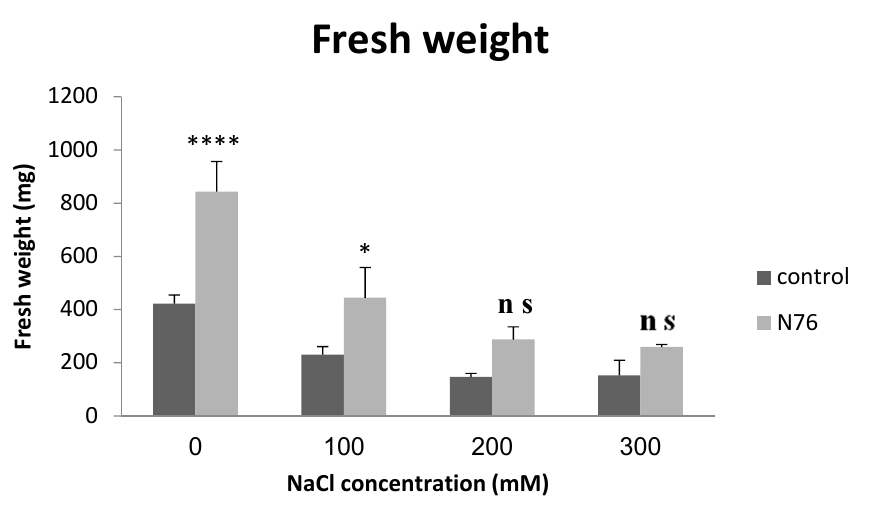
Figure 3. Effect of P. azotoformans on fresh weight of wheat seedlings under different NaCl concen- trations. ns: no significant difference; *: significant difference ( p < 0.05); ****: significant difference ( p < 0.0001).